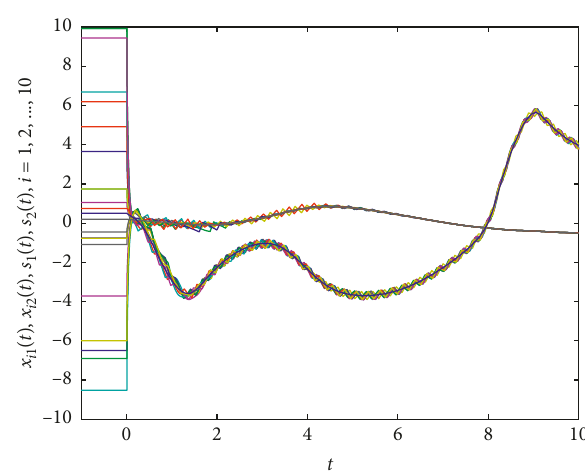
( t ) , x ( t ) , and s ( t ) i 1 i 2